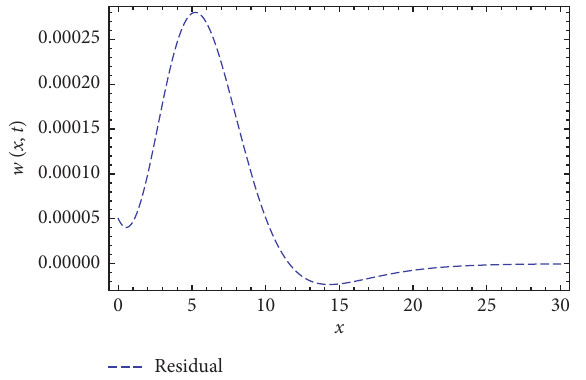
Figure 3: Residual of w ( η ,t ) by OHAM-DJ at t � 0 .